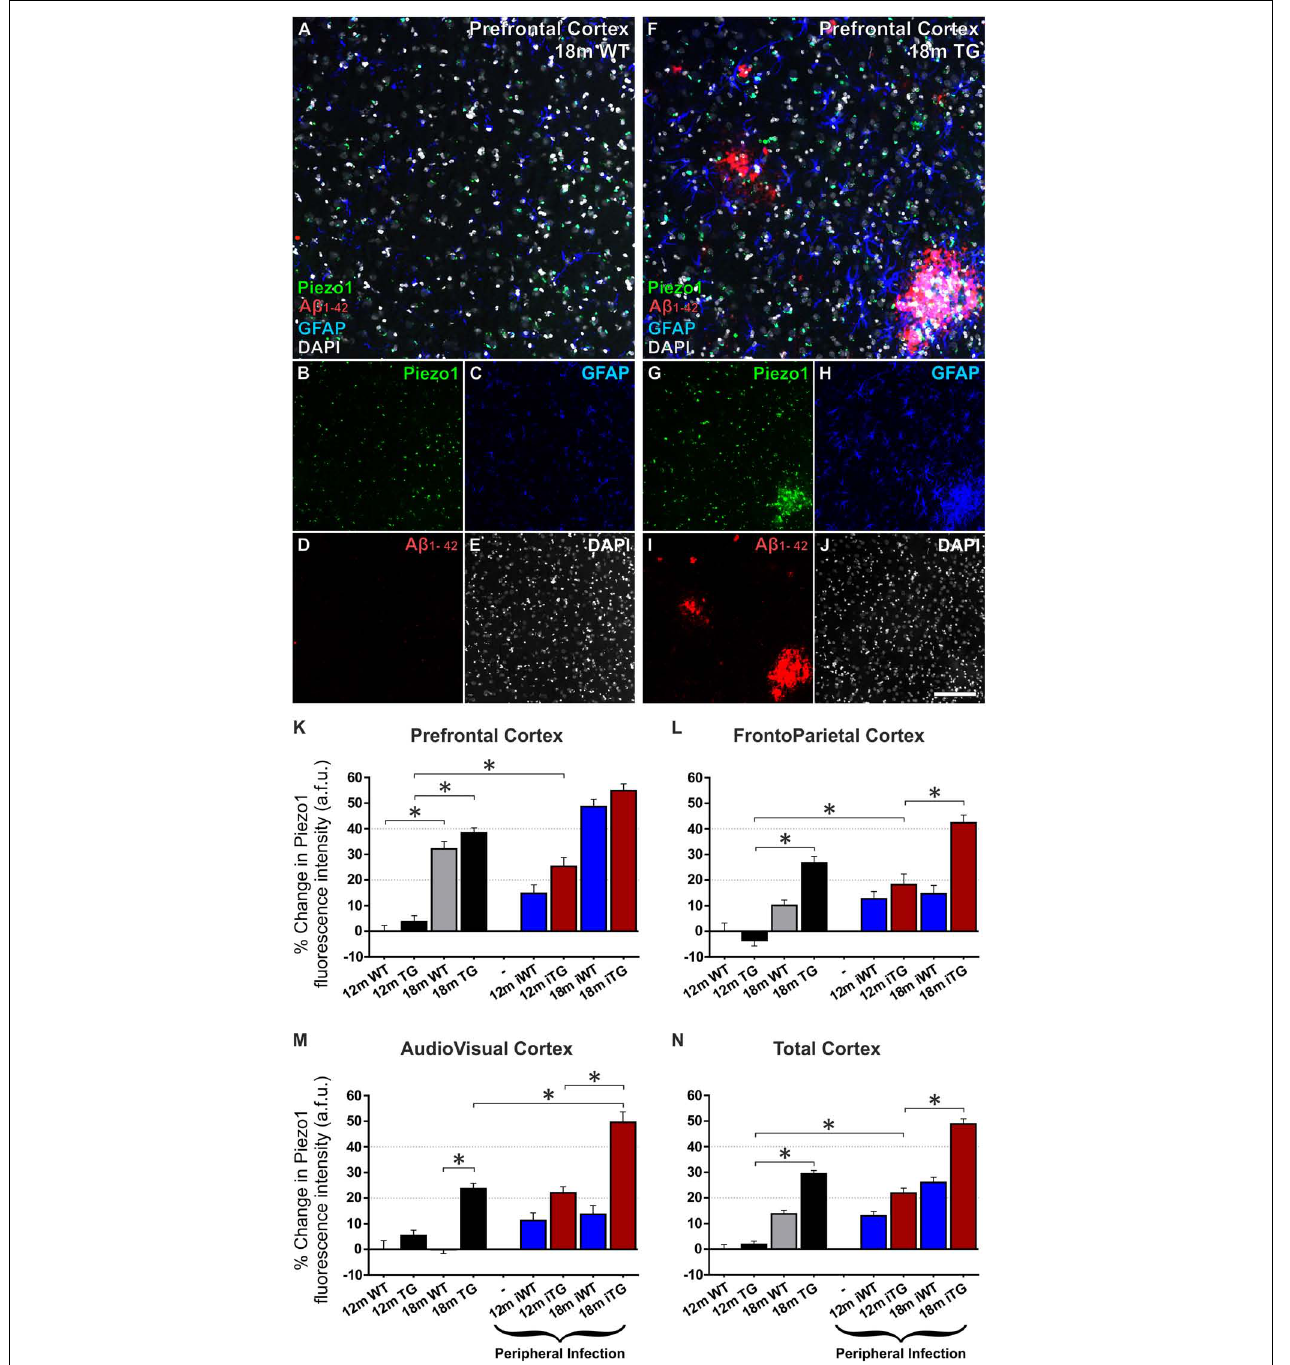
FIGURE 5 | Mechanosensing Piezo1 channel expression increases in the cerebral cortex of TgF344-AD rats with a urinary tract infection (UTI). Sagittal sections (lateral –1.9 mm) of wild-type (WT) Fisher and TgF344-AD rat brains were immunofluorescently stained for Piezo1 (N-terminal antibody), conformation-specific A β 1 − 42 , GFAP, and DAPI. Shown are representative images of the prefrontal cortex of an 18-month WT rat (A–E) and an 18-month TgF344-AD (18 m TG) (F–J) . Scale bar = 150 µ m. Elevations in Piezo1 channel expression with age, Alzheimer’s disease (AD) pathology and peripheral infection were measured in three distinct areas of the cerebral cortex, i.e., the prefrontal cortex (K) , the frontoparietal cortex (L) , and the audiovisual cortex (M) . In addition, Piezo1 expression was averaged over all three regions to illustrate changes in channel expression in the total cerebral cortex (N) . Data were normalized to 12 month wild-type (12m WT) values for each cortical region and are represented as the mean ± SEM of the percentage change from the 12m WT groups. Three-way ANOVAs with Holm-Sidak post hoc tests were performed to test for interactions between age, genotype, and peripheral infection. ∗ Represents a change > 20% and a p -value < 0.01. There were 5–6 rats per group and 2–3 brain sections per animal. Ten regions of interest (ROI) were analyzed per cortical region per section, i.e., 100–180 ROIs analyzed per group.